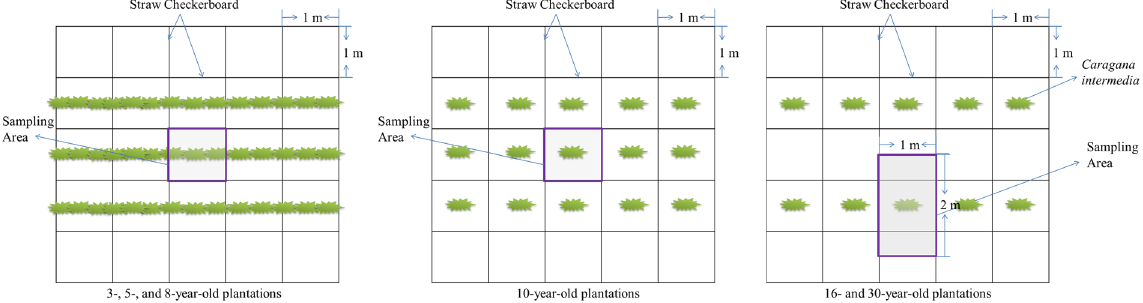
Figure 4. The sampling area of different ages for the C. intermedia